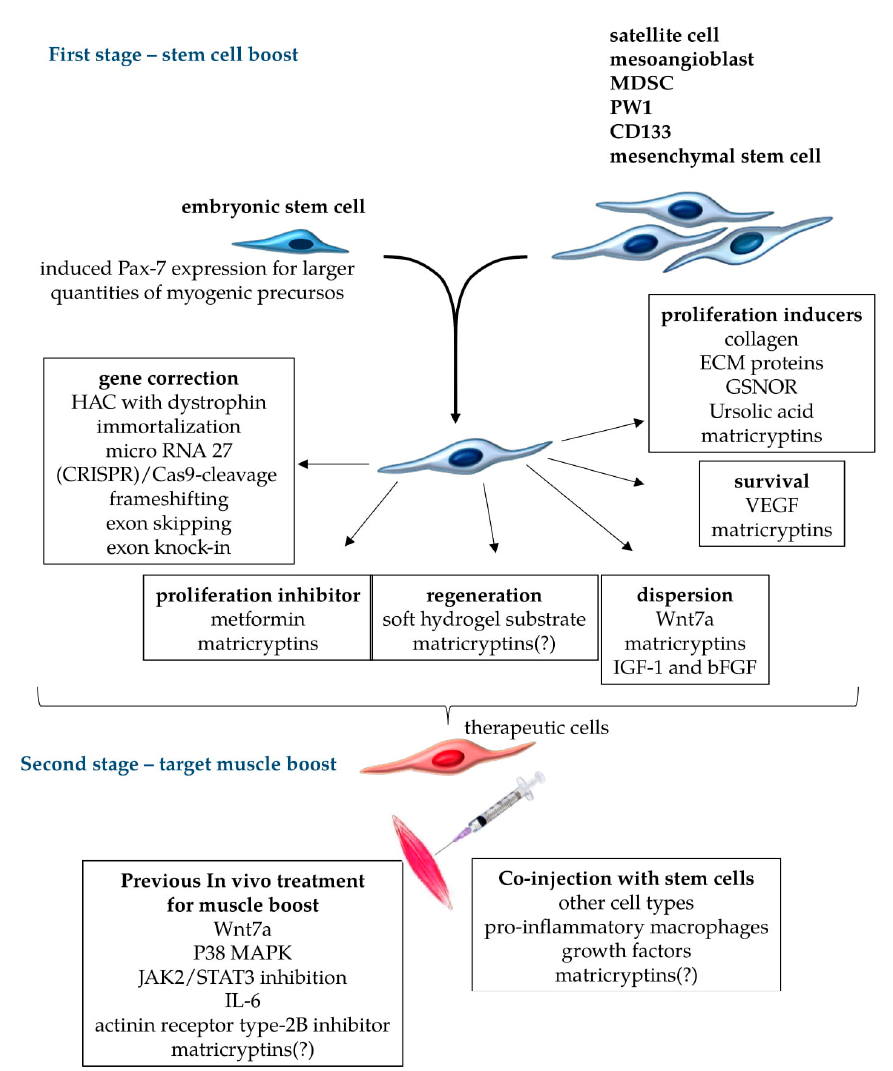
Figure 3. Treatments for stem cells and target muscles to improve stem-cell-based cellular therapy proposals. Di ff erent cell types can be used for therapeutic transplants in muscular dystrophies, including embryonic stem cells with the induced expression of (paired box protein) Pax7 for myogenic commitment, and muscle cells such as satellite cells, mesoangioblasts, (muscle-derived stem cell) MDSC, PW1, CD133, and mesenchymal stem cells. For transplant therapy, appropriate stem cells should be submitted to gene correction procedures to restore the normal production of functional, unmutated proteins. Further cellular boost could aim to reversibly inhibit proliferation (when terminal di ff erentiation is necessary), induce terminal muscle di ff erentiation and dispersion of stem cells through the treated muscles, increase the survival rate of transferred cells, and induce proliferation to expand the population of cells to be engrafted. These cellular in vitro treatments comprise the first stage of the boosts, which can be done in di ff erent combinations to improve engraftment, focusing on particular necessities of each muscular dystrophy. The second stage of treatment should target the muscles that receive boosted cells. In this case, the muscles can be pre-treated with chemical metabolic regulators to facilitate cellular engraftment, or receive the co-injection of other cell types, growth factors, and other components to improve the transplant. Matricryptins are a family of pleiotropic biologically active peptides derived from extracellular matrix components that serve many of these functions, as observed in tumor cells. Matricryptins are described as modulators of cellular migration, proliferation, adhesion, and cell survival. It is yet to be shown whether matricryptins can induce the regeneration of stem cells into muscle fibers, and the nature of their activities in the environments of di ff erent muscles (indicated by “?” in the